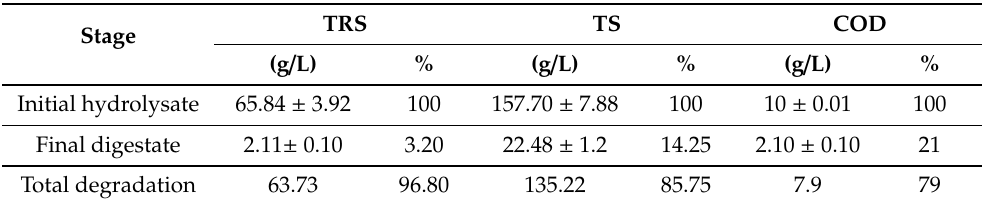
Table 5. Results of concentrations of total reducing sugars (TRS), Total sugars (TS) and chemical oxygen demand (COD) of the digestate with respect to the substrate.